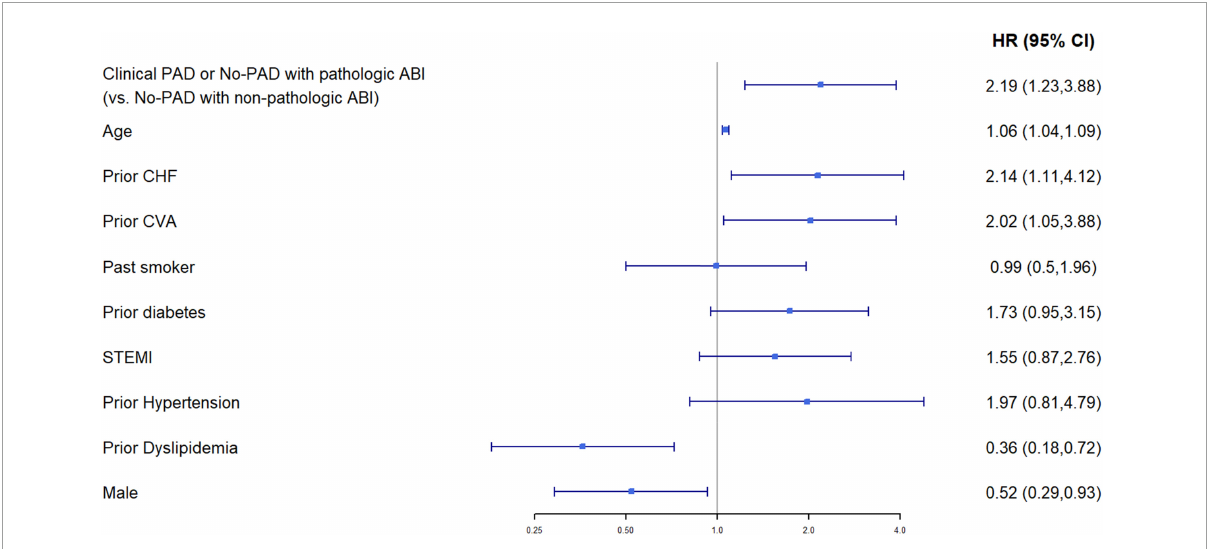
FIGURE4 Multivariable Cox proportional hazard model for 1-year mortality (95%CI). Baseline characteristics ( p < 0.05 for comparison between the groups of clinical PAD or no PAD with pathological ABI, vs. no PAD with non-pathological ABI) were chosen as covariates. Model’s data contain only patients with non-missing values in these variables, N = 1,035